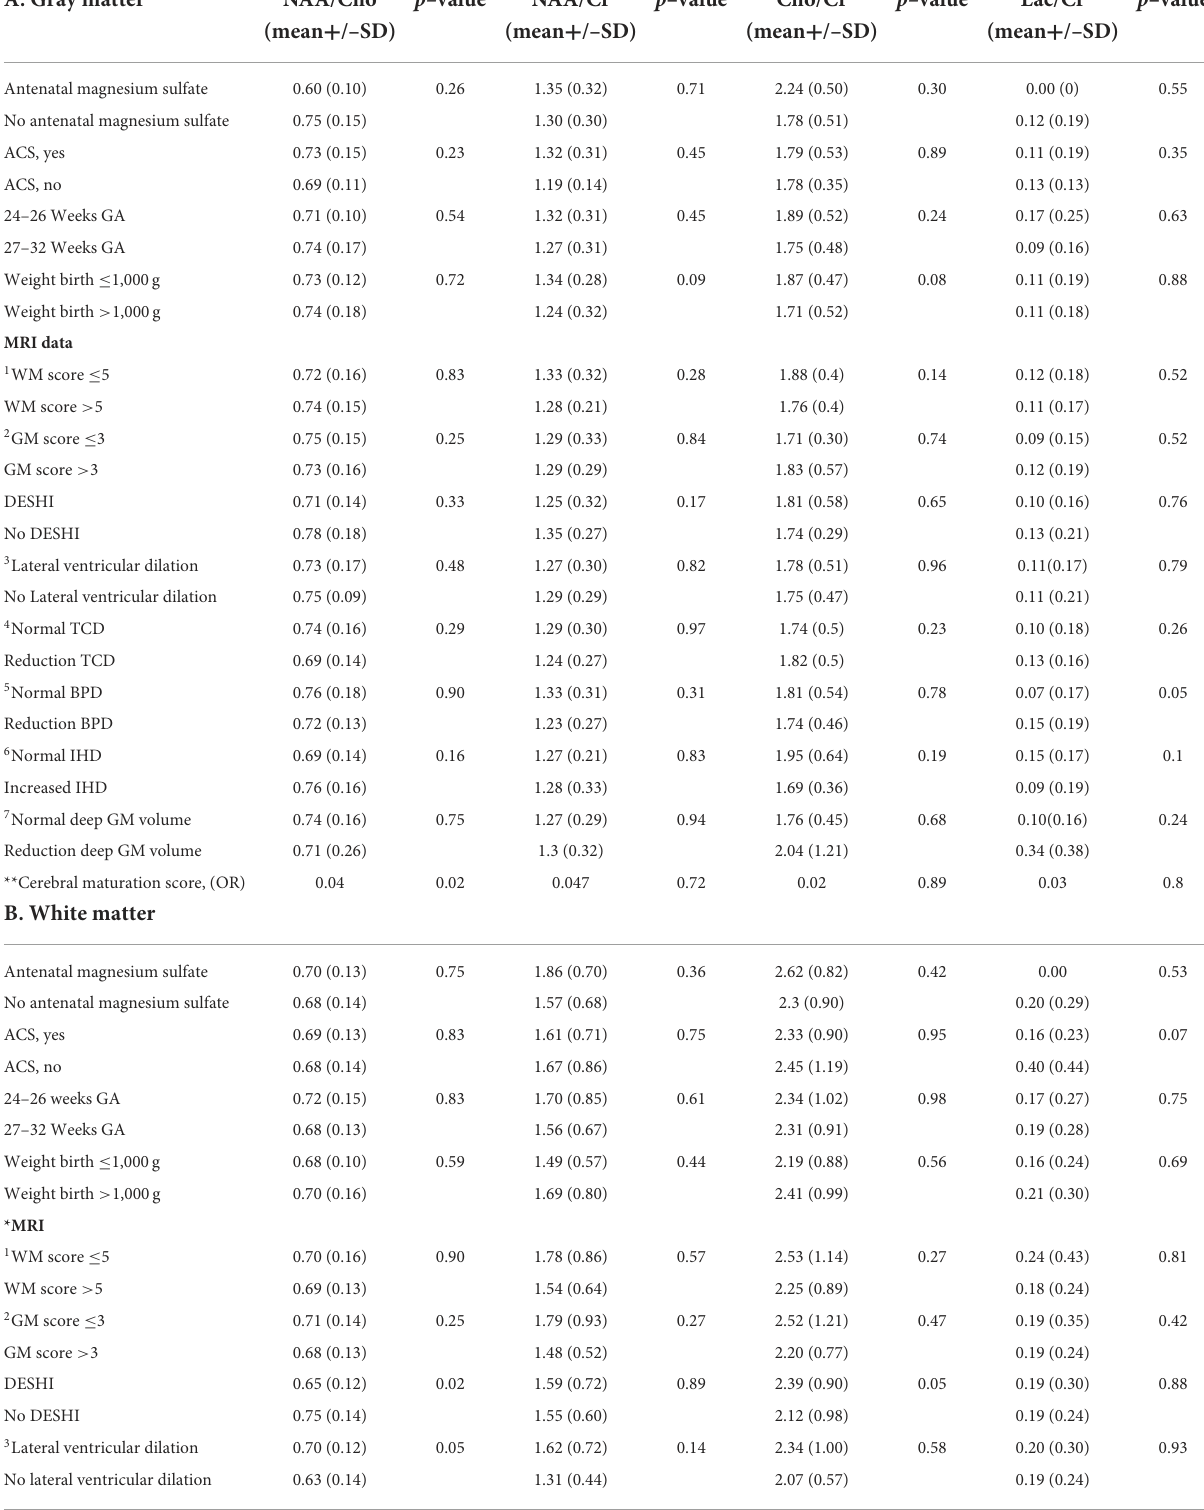
TABLE 5 Correlation between mean metabolite peak area ratios in gray matter (A) and white matter (B) with perinatal characteristic and brain MRI abnormality at